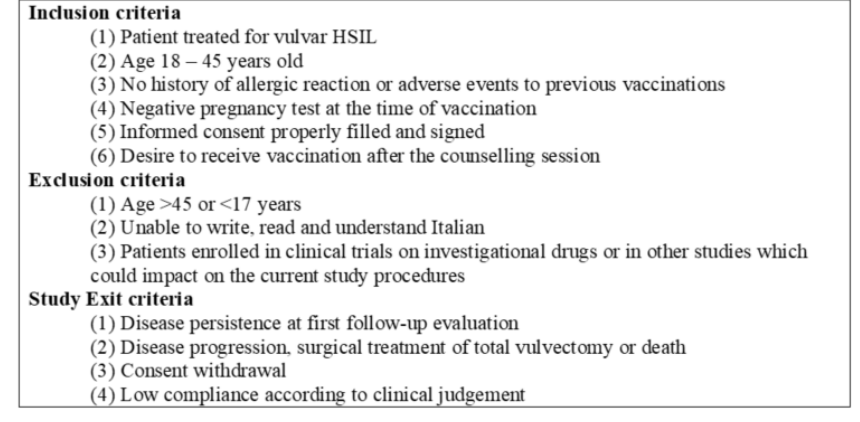
Figure 1. Enrolment criteria.